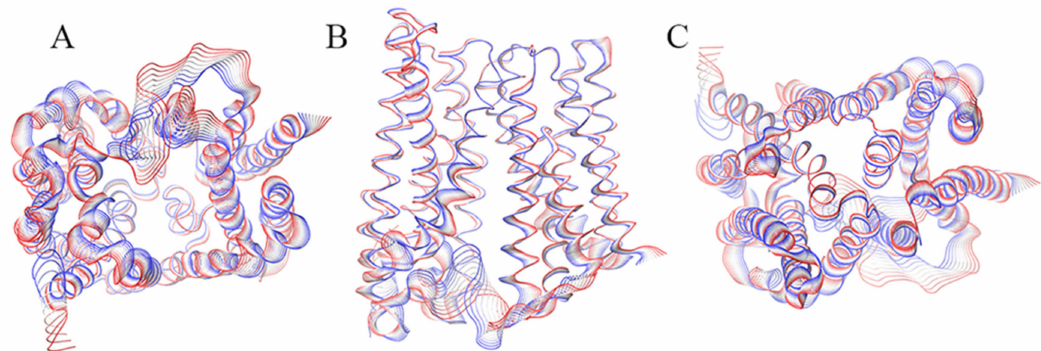
Figure 1. Graphical representation of the motion projections identified along the first eigenvector on the three-dimensional structure of the BdFpn. ( A ) Inward side view; ( B ) View along the membrane plane; ( C ) Outward side view. The width of the ribbon, generated by the flanking tubes, indicates the amplitude of the motion while the transition from red to blue indicates the motion direction.